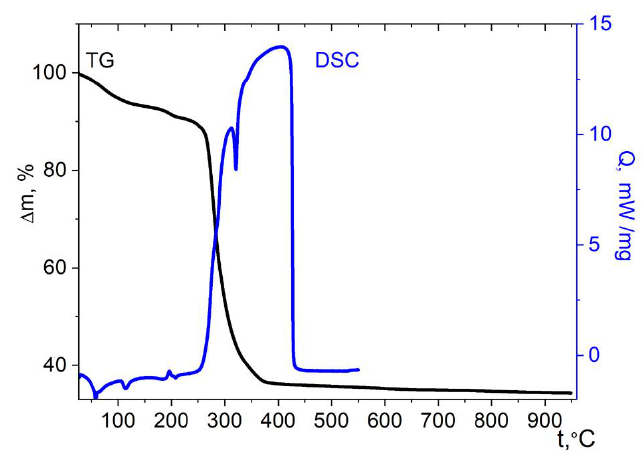
Figure 10 . Thermolysis of complex 2 under air.